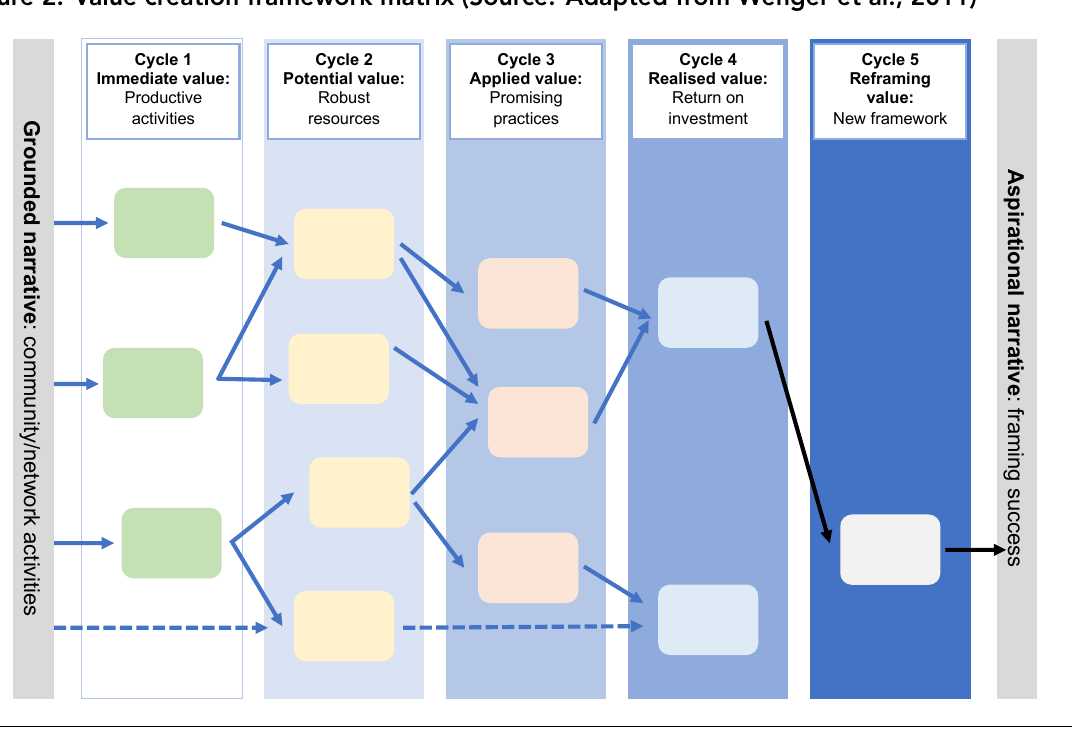
Figure 2. Value creation framework matrix (Source: Adapted from Wenger et al.,